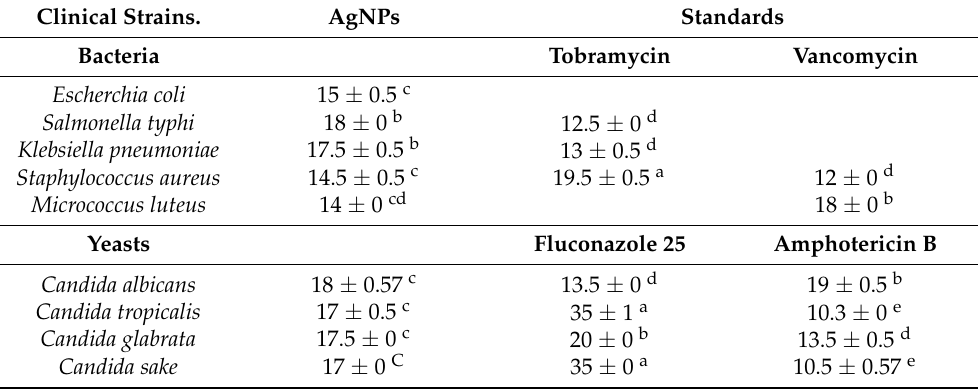
Table 1. The antibacterial and anti-Candida activities of the biosynthesized AgNPs from Aeonium haworthii . Values present the zone inhibition against the tested strains expressed in mm. Means with the same letter are not significantly different from each other ( P>0.05 )